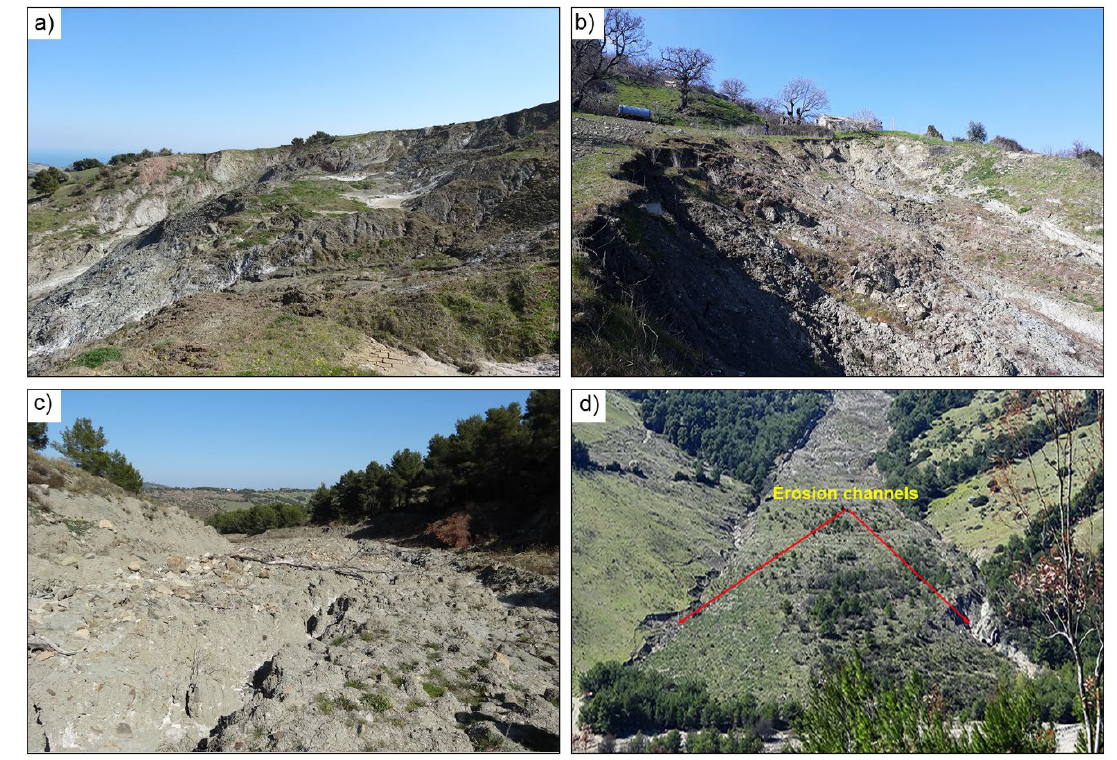
Figure 6. ( a ) A sector of the uppermost location of the source area situated on the right side of the landslide area, affected by several slides; ( b ) detail of the active main scarp of the source area situ- ated on the left side of the landslide area; ( c ) upper portion of the transition zone; and ( d ) toe sector of the landslide characterized by deep erosive channels along the right and left sides of the accumu- lation zone.